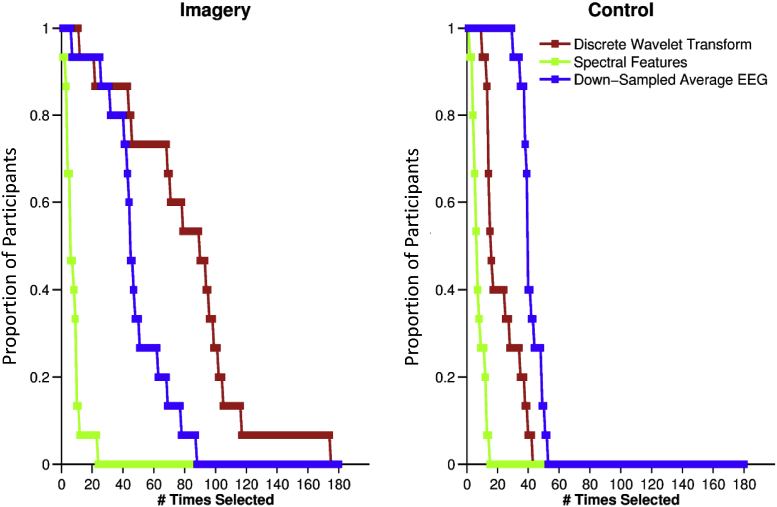
Frequency of selecting each family of features. After the feature extraction stage, a feature selection process determines which features were most suitable for classification. The X-axis (# Times Selected) represents the number of times each feature family appeared across participants. Y-axis (% participants) shows the proportion of participants in whom that particular number of features was selected.